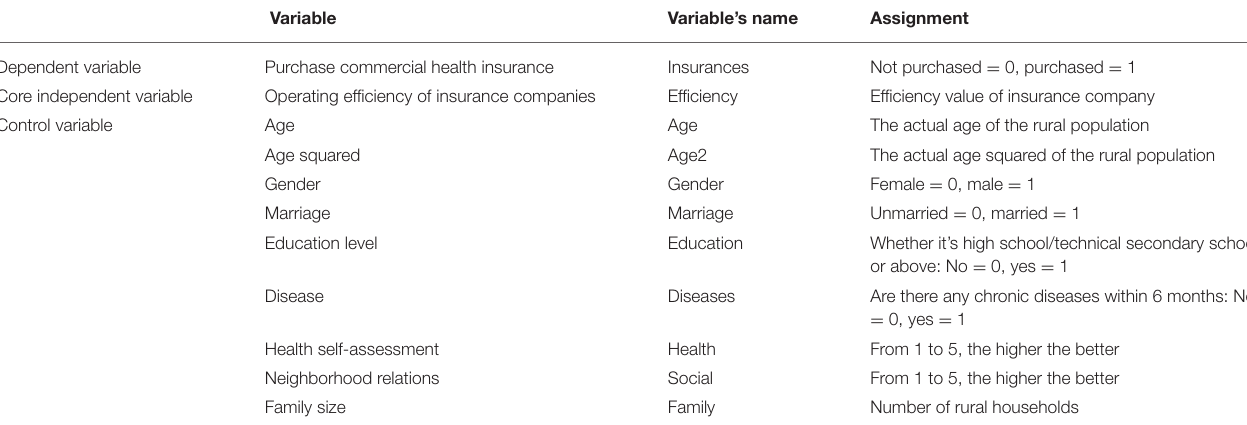
TABLE 1 | Description and assignment of the variables.